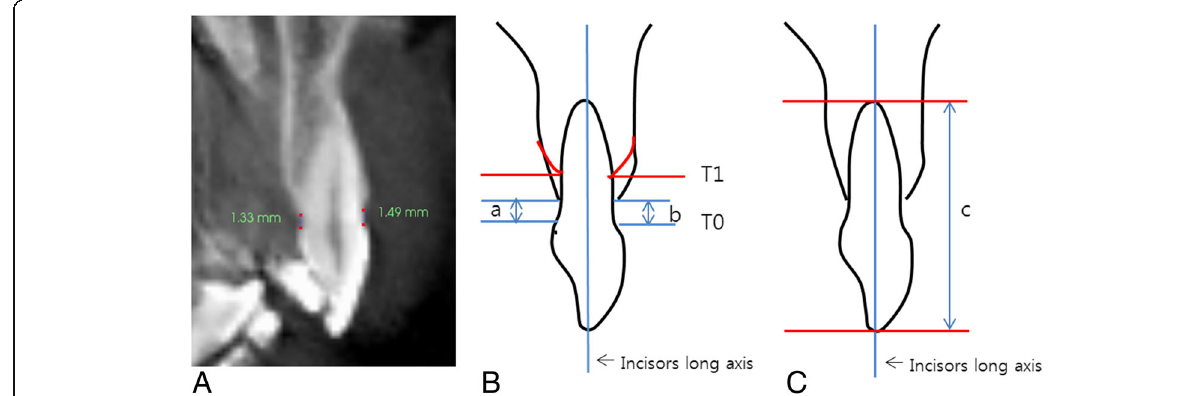
Fig. 4 Reorientation of CBCT images for alveolar bone thickness and root length measurement. a Reoriented CBCT image. b Vertical alveolar bone level on palatal (a) and labial side (b). c Root